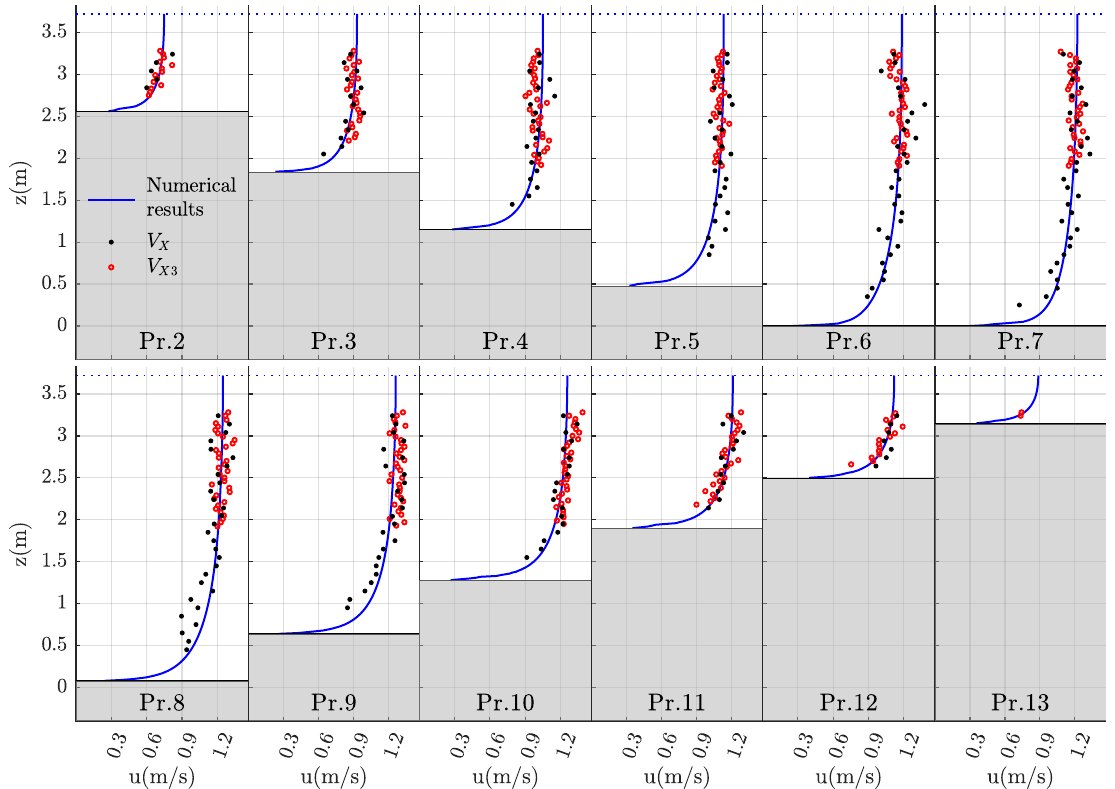
Figure 7. Measured velocities ( V X and V X 3 ) and hydraulic model results for measured verticals in measurement 2b of section